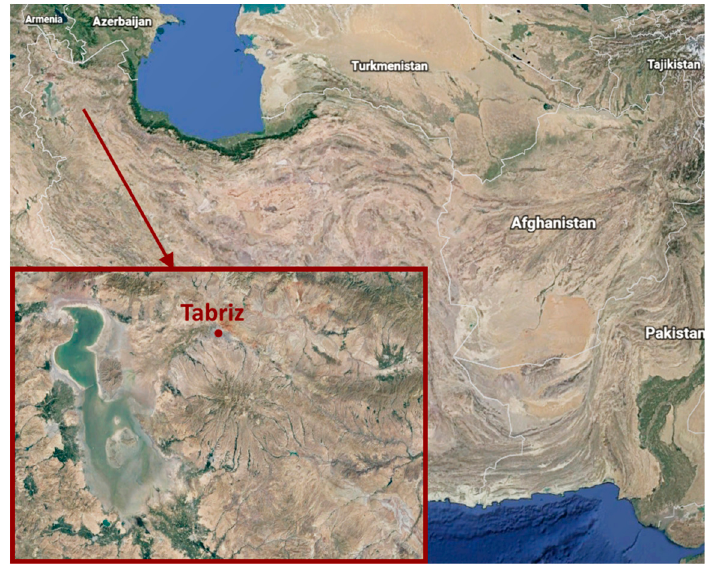
Figure 1. Location of the study area [19].